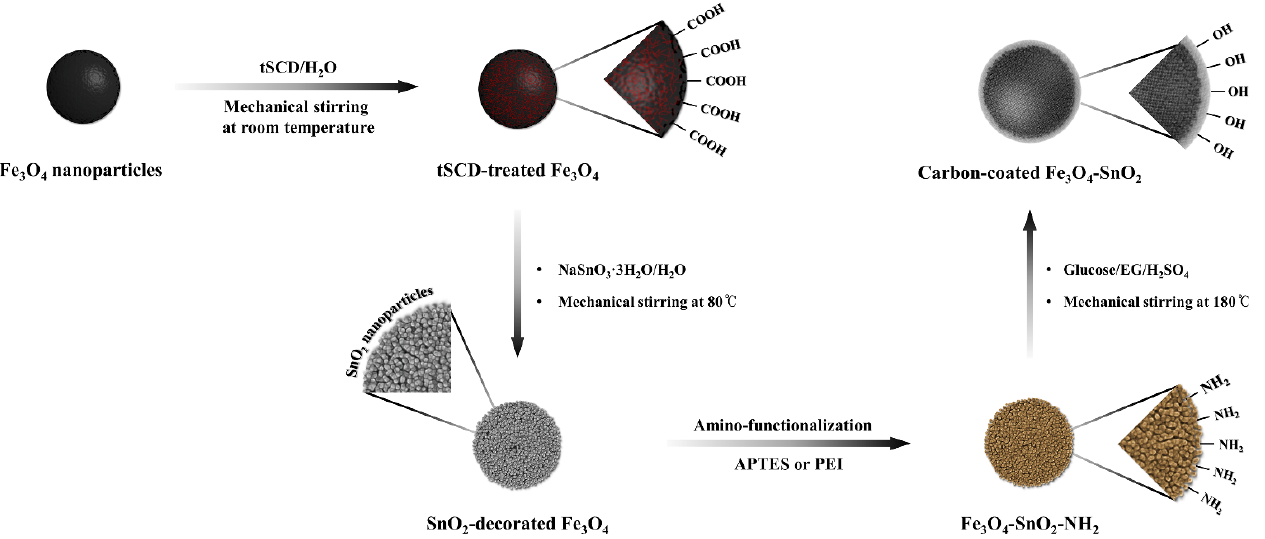
Figure 1. Schematic for the preparation of the Fe 3 O 4 -SnO 2 -C nanoparticles.